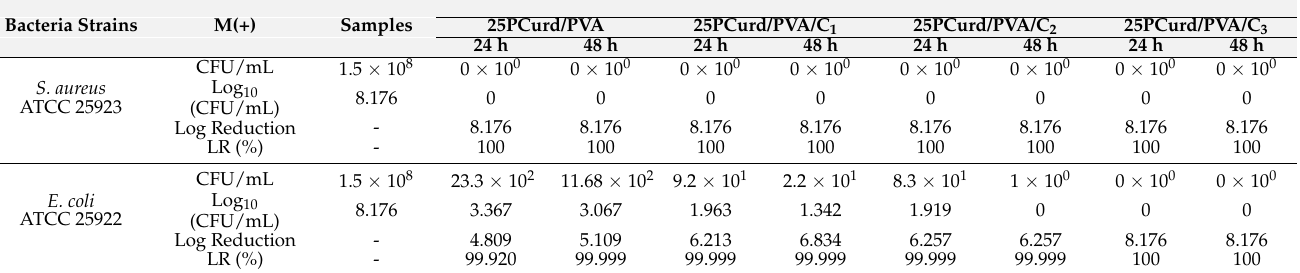
Table 4. Bacterial logarithmic reduction after 24 h and 48 h of contact with 25PCurd/PVA electrospun membrane with and without